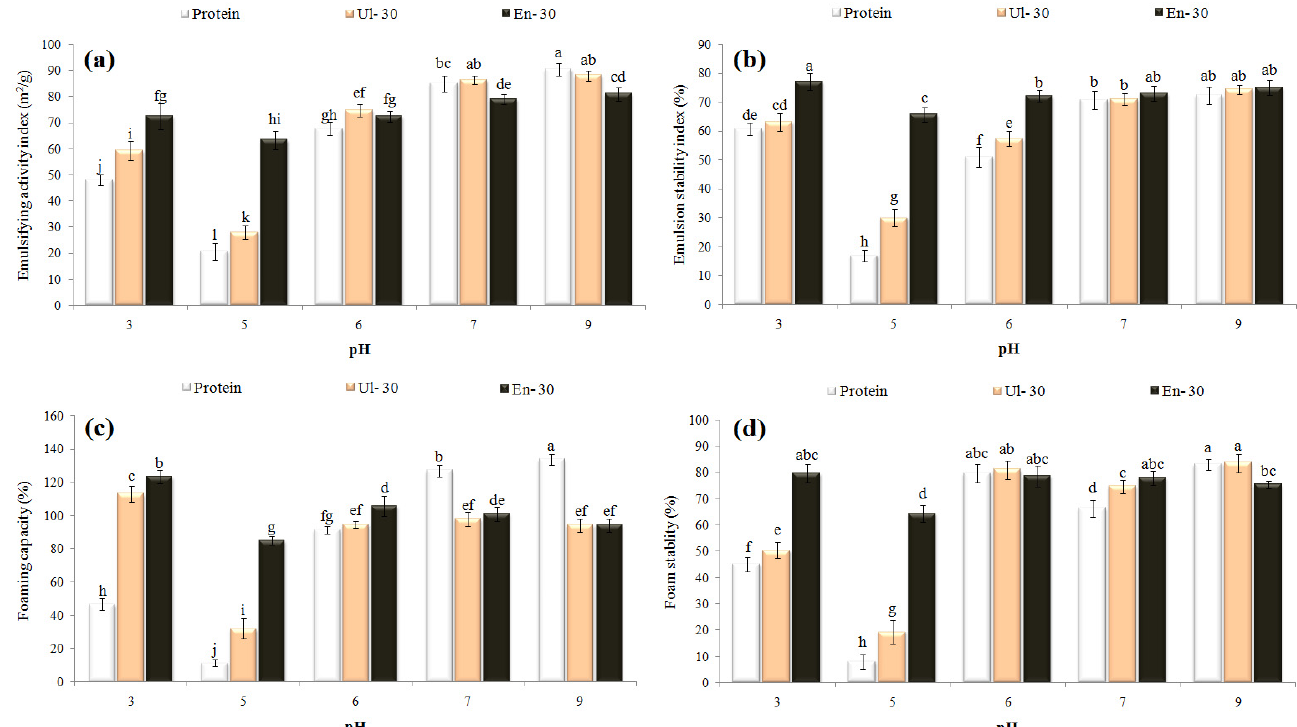
Figure 3. Emulsifying activity ( a ), emulsion stability ( b ), foaming capacity ( c ), and foaming stability ( d ) for intact WPC and WPC modified by sonication or enzymolysis for 30 min (Ul-30/H-30), at different pH values. Data are presented as mean ( n = 3) with standard deviation (the same letters above bars indicate that the differences between average values were statistically not significant at p < 0.05).